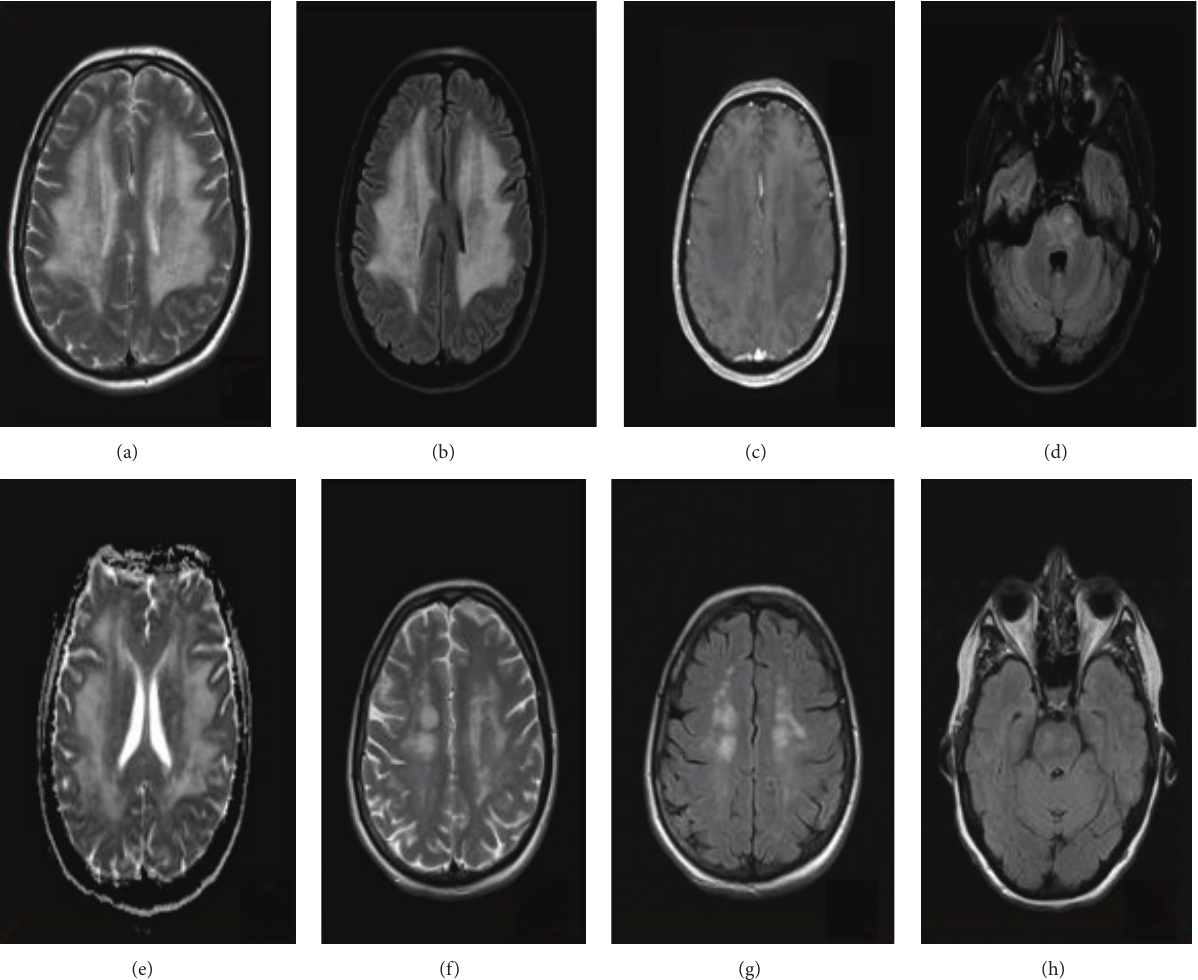
Figure 1: T2-weighted and FLAIR MRI revealed the presence of a high signal intensity mainly in periventricular and subcortical white matter of the bilateral cerebral hemispheres (a, b) and pons (d), without gadolinium enhancement on T1-weighted sequence (c). ADC maps showed increased signal intensity suggestive of vasogenic edema (e). The high signal intensity detected in the deep white matter of bilateral cerebral hemispheres was significantly reduced one year after the onset of symptoms under metronomic chemotherapy ((f) axial T2-sequence; ((g) and (h)) axial